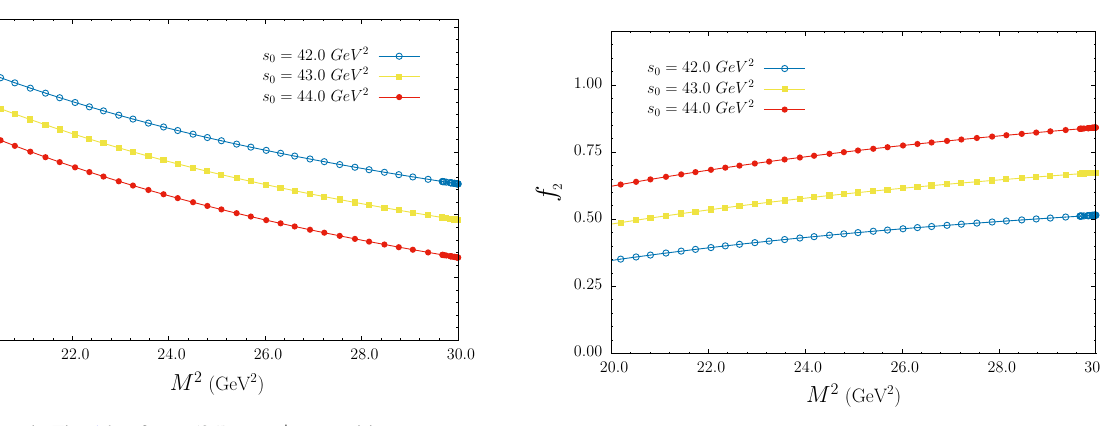
Fig. 2 Same as in Fig. 1 but for B s ( 2 S ) → B ∗ K transition